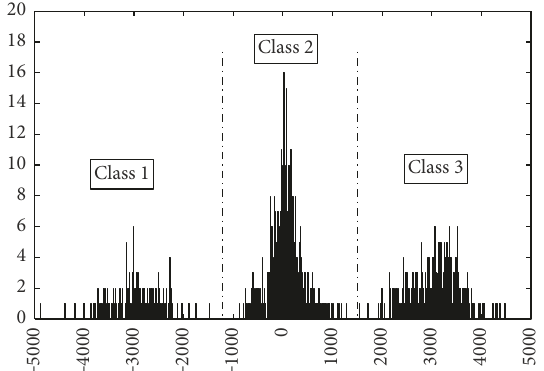
Figure 5: The distribution of the statistic feature values of track 1 after MP3 compression at 64